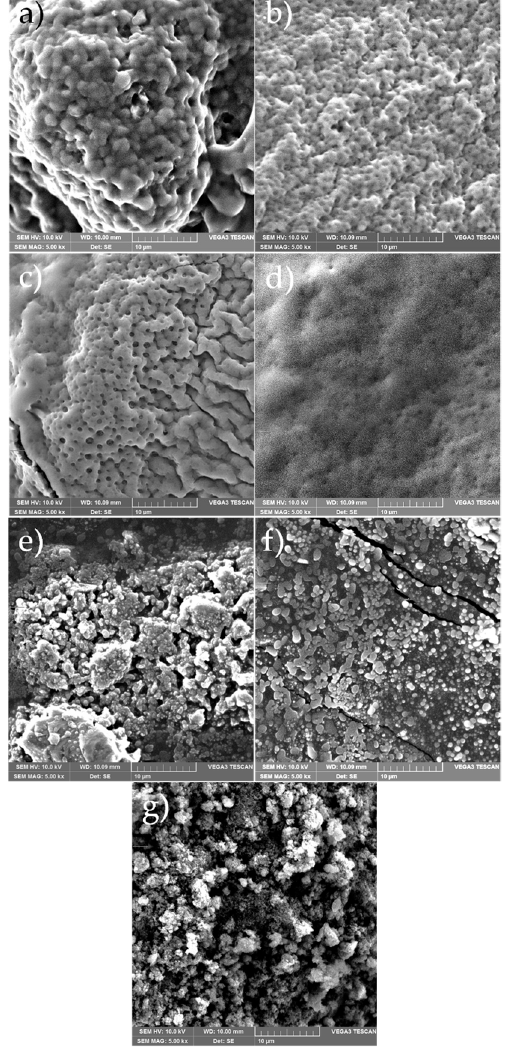
Figure 11. SEM pictures of sample ( a ) PThBr, ( b ) TE 1:0.2, ( c ) TE 1:0.6, ( d ) TE 1:1, ( e ) TE 0.6:1, ( f ) TE 0.2:1, and ( g ) PEDOT.